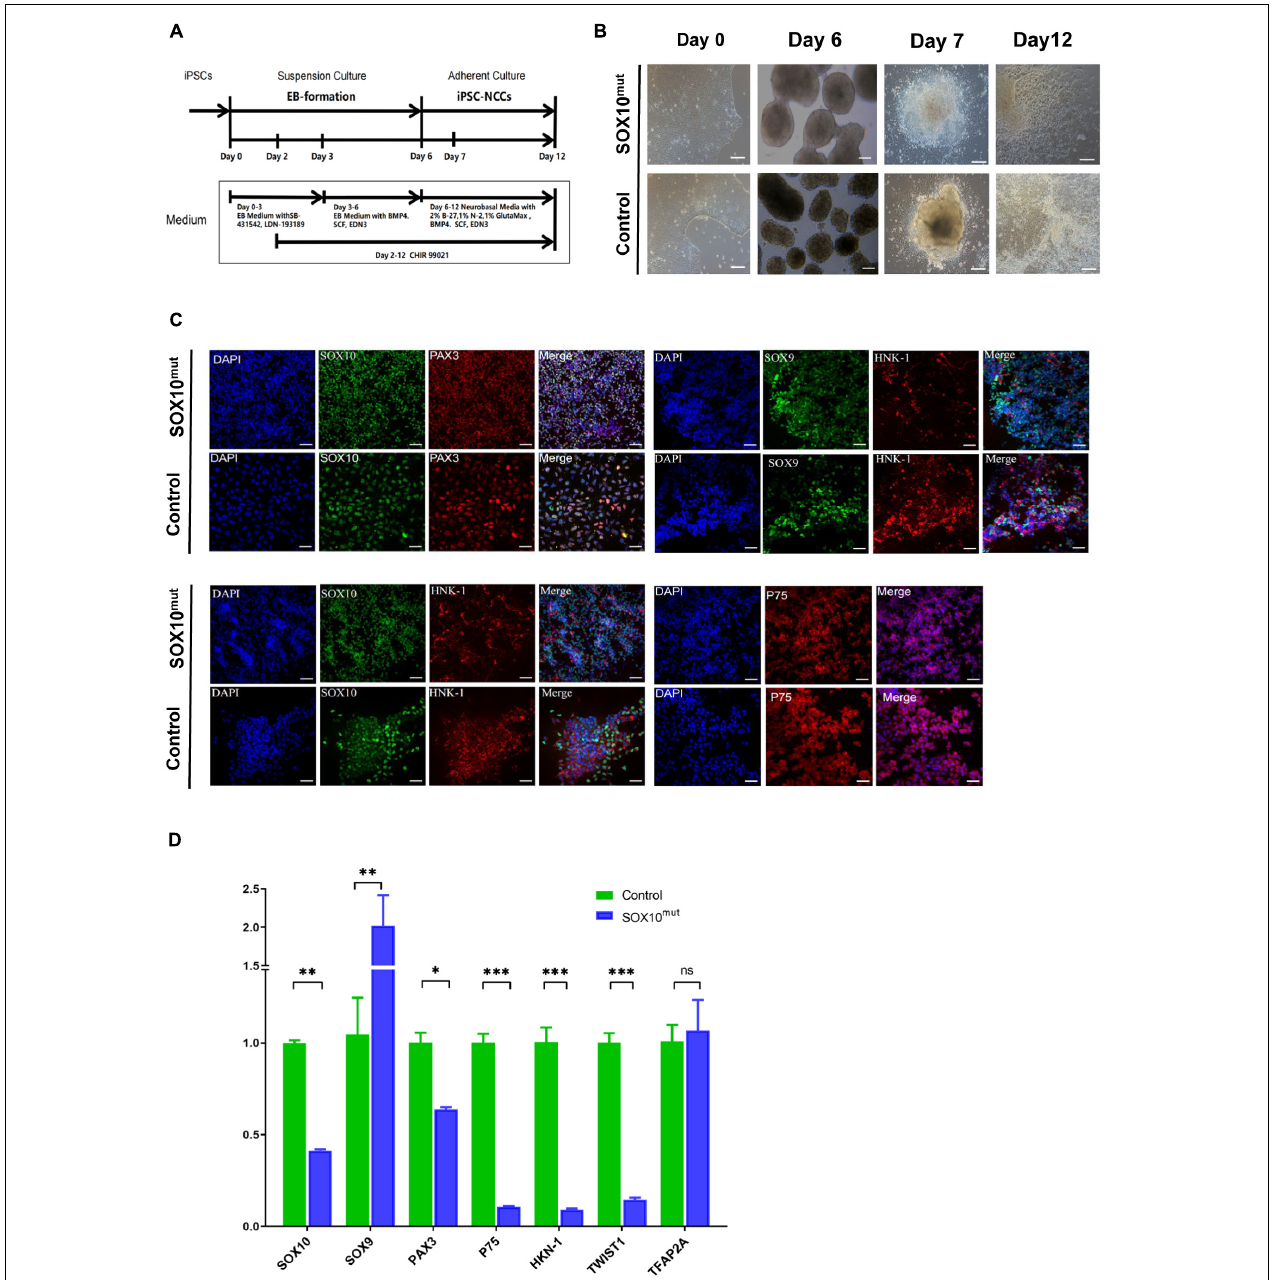
FIGURE 6 | Generation and characterization of SOX10 mutant iPSC-derived NCCs. (A) Schematic of the NCC differentiation protocol timeline. EB Medium: KO-DMEM supplemented with 20% KSR, 1% GlutaMax-I, 1%NEAA. (B) Comparison of the cell images of the SOX10 mutant and control iPSC-derived NCC at Days 0, 6, 7, and 12 following differentiation. Bar, 100 µ M. (C) Immunofluorescence staining shows expression of NCC markers SOX10, PAX3, SOX9, HNK-1, and P75. Bar, 50 µ M. (D) RT-qPCR for evaluating expression of NCC markers. ( ∗ represents p < 0.05, ∗∗ represents p < 0.01, ∗∗∗ represent p < 0.001 and ns represents no